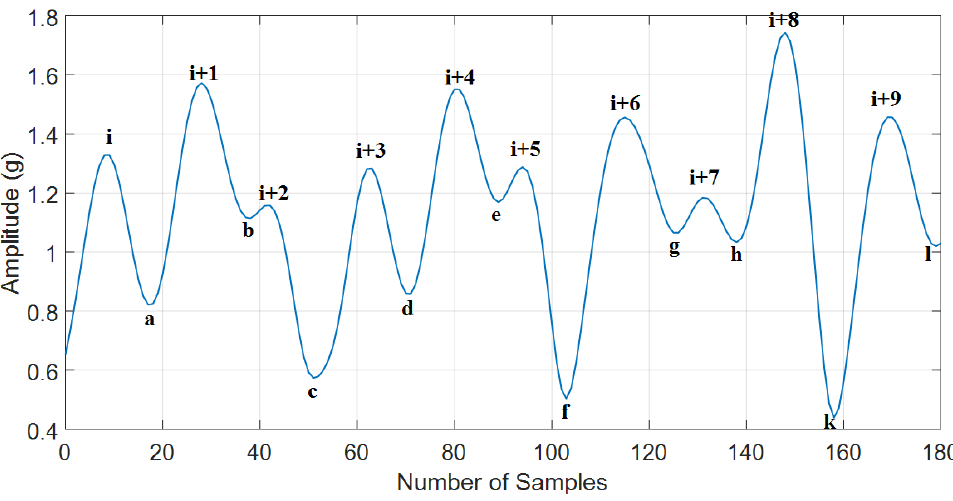
Figure 5. The minimal peak prominence definition.